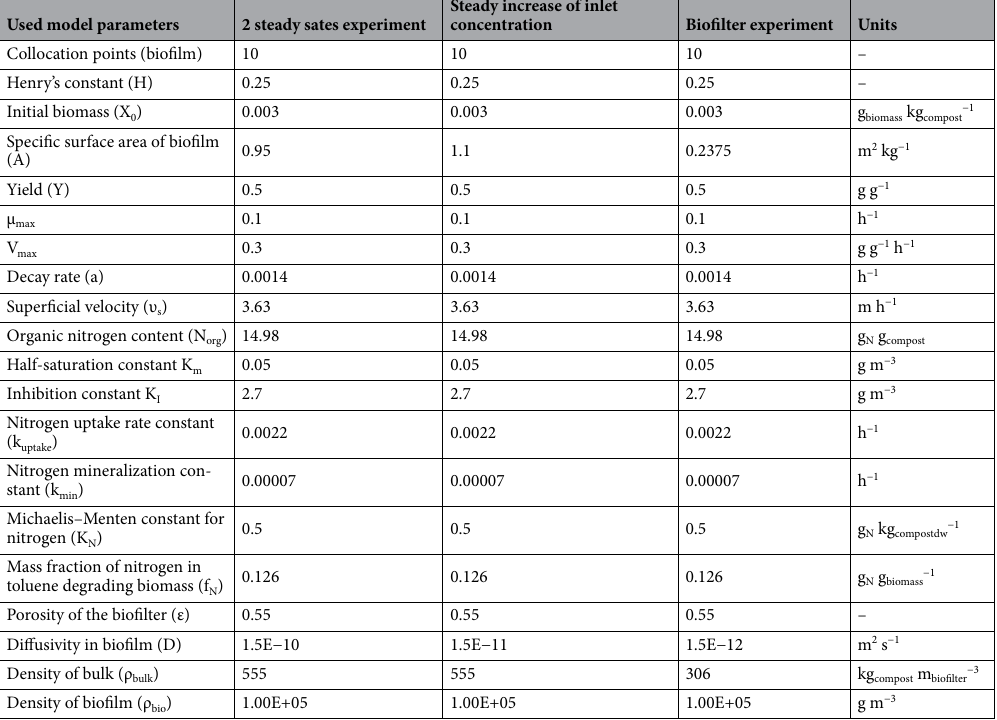
Table 2. Used model parameters for all simulations 33,34